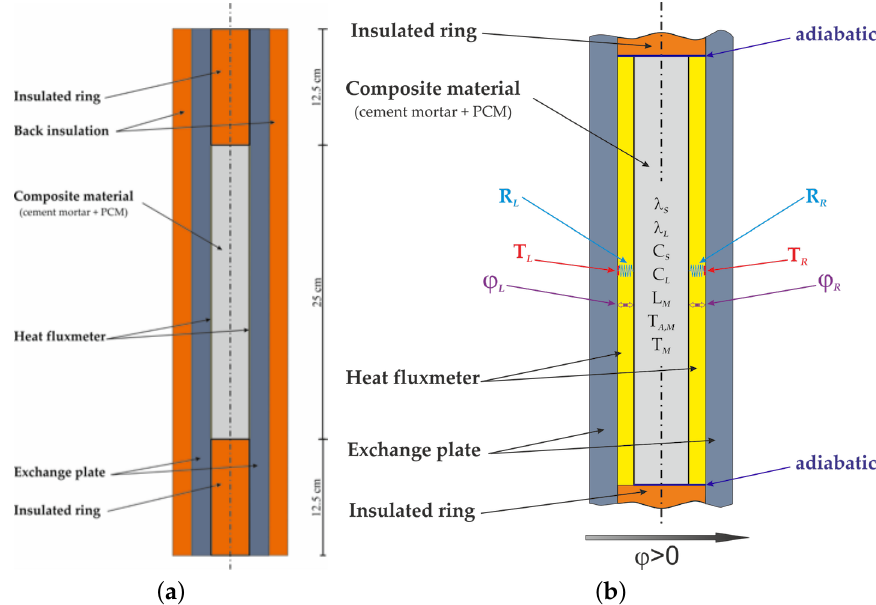
Figure 3. Detailed description of the experimental set-up. ( a ) Schematic view; ( b ) Detailed view (with boundary